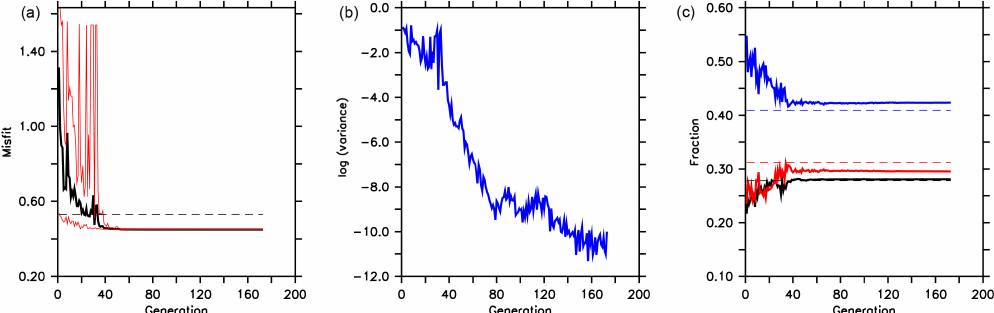
Figure 10. As Fig. 7, but for optimization OBS-WIDE-20. The optimization finished at generation 173.